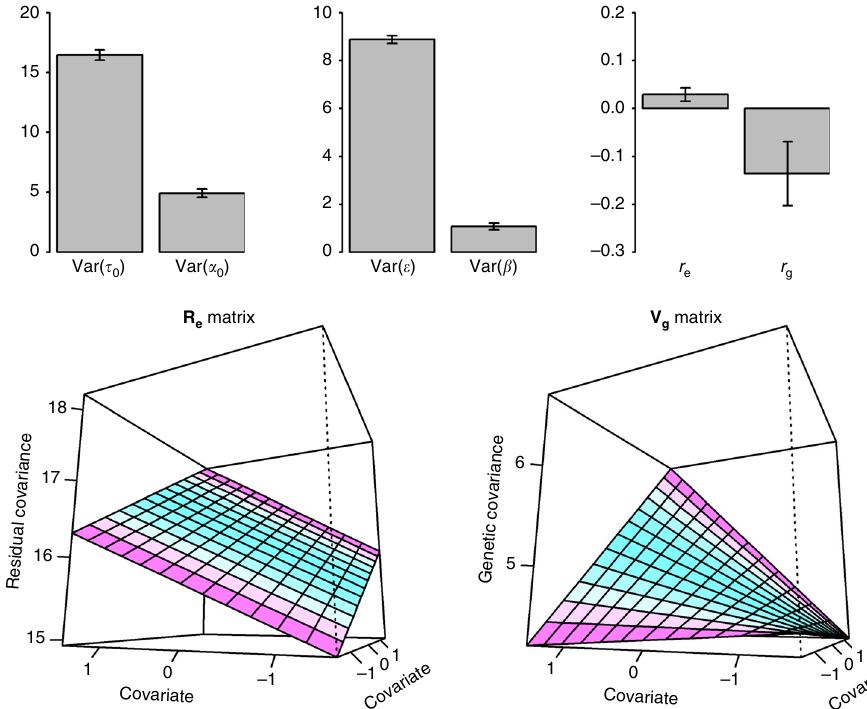
Fig. 7 Estimated variance components and correlations from MRNM for BMI-NEU analysis. Var( τ 0 ): Estimated residual variance for BMI as the main outcome. Var( α 0 ): Estimated genetic variance for BMI as the main outcome. Var( ε ): Estimated residual variance for NEU as the covariate. Var( β ): Estimated genetic variance for NEU as the covariate. r e : Estimated residual correlation between BMI and NEU. r g : Estimated genetic correlation between BMI and NEU. Error bars are 95% con fi dence interval. R e matrix is the residual (co)variance structure between different covariate levels (see Eq. 4), which is derived based on the estimated random regression coef fi cients and polynomial matrix as R e = Φ M y Φ ′ . Φ is the matrix of polynomials evaluated at given covariate values, where entries of the fi rst column are all 1 s and the second column is the standardised covariates of respective individuals. M y is the variance – covariance ¼ . V matrix of random regression coef fi cients estimated from MRNM as M g matrix in is y the genetic (co)variance structure between different covariate levels (see Eq. 2), which is derived based on the estimated random regression coef fi cients and polynomial matrix as V g = Φ K y Φ ′ . Φ is the matrix of polynomials evaluated at given covariate values, where entries of the fi rst column are all 1 s and the second column is the standardised covariates of respective individuals. K y is the variance – covariance matrix of random regression coef fi cients estimated ¼ from MRNM as K y